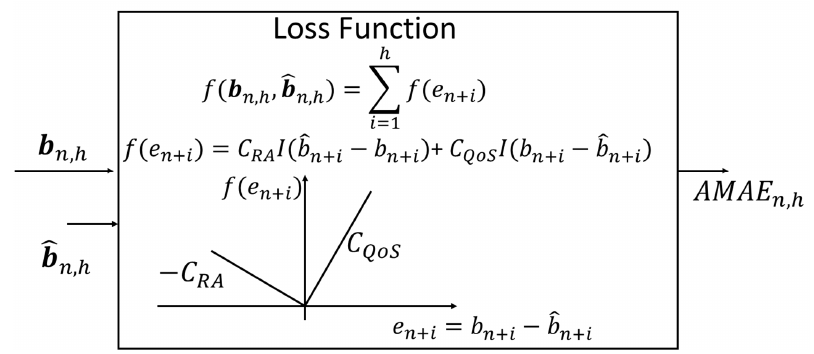
Figure 3. Definition of the asymmetric loss